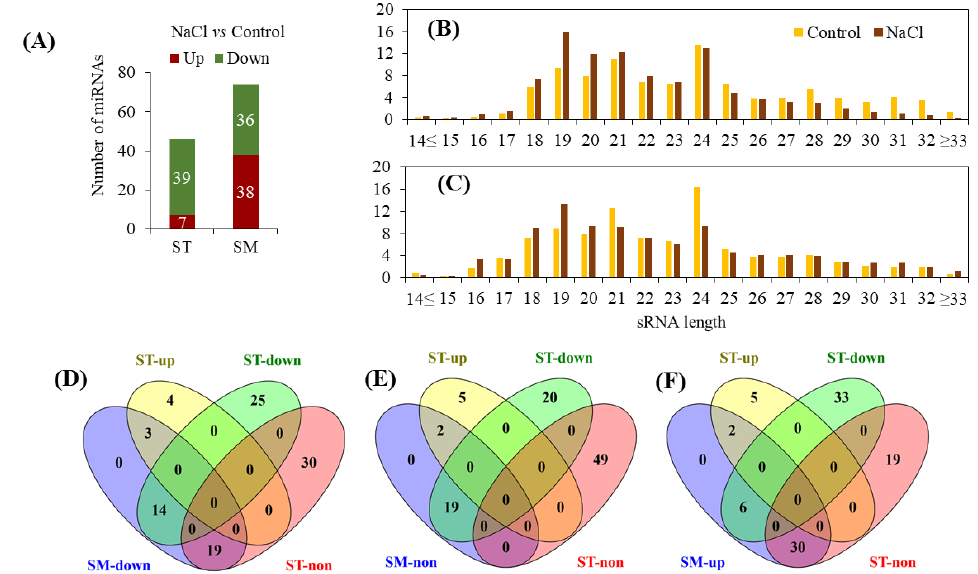
Figure 2. Analysis of the differentially expressed miRNAs from the roots of Suntop (ST) and Sunmate (SM). ( A ) Number of miRNAs in control and NaCl-treated roots of the two wheat cultivars. Length distributions of differentially expressed ( B ) known and ( C ) novel miRNA in the roots of both cultivars. The Venn diagrams show the number of miRNAs regulated by the salinity treatment and the overlapping patterns between the two cultivars. The data are overlaps of miRNA in Suntop, which are down-regulated ( D ), unchanged ( E ) and up-regulated ( F ) in Sunmate. Within each genotype, miRNAs having fold change (salinity vs. control) of log 2 N ≥ 1 are considered as up-regulated, those between 0 < |log 2 N| < 1 are considered as unchanged, and those with a change of log 2 N ≤ − 1 are considered as down-regulated, p <